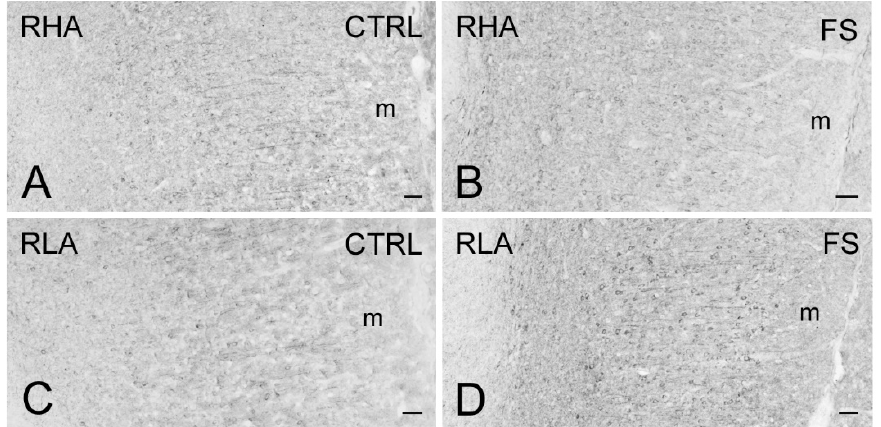
Figure 12. trkB receptor-like immunoreactivity (trkB-LI) in the infralimbic (IL)/prelimbic (PL) region of the medial prefrontal cortex of RHA ( A , B ) and RLA rats ( C , D ) under baseline conditions (CTRL) and after a 15 min session of forced swimming (FS). m, molecular layer. Scale bars: 25 µm.